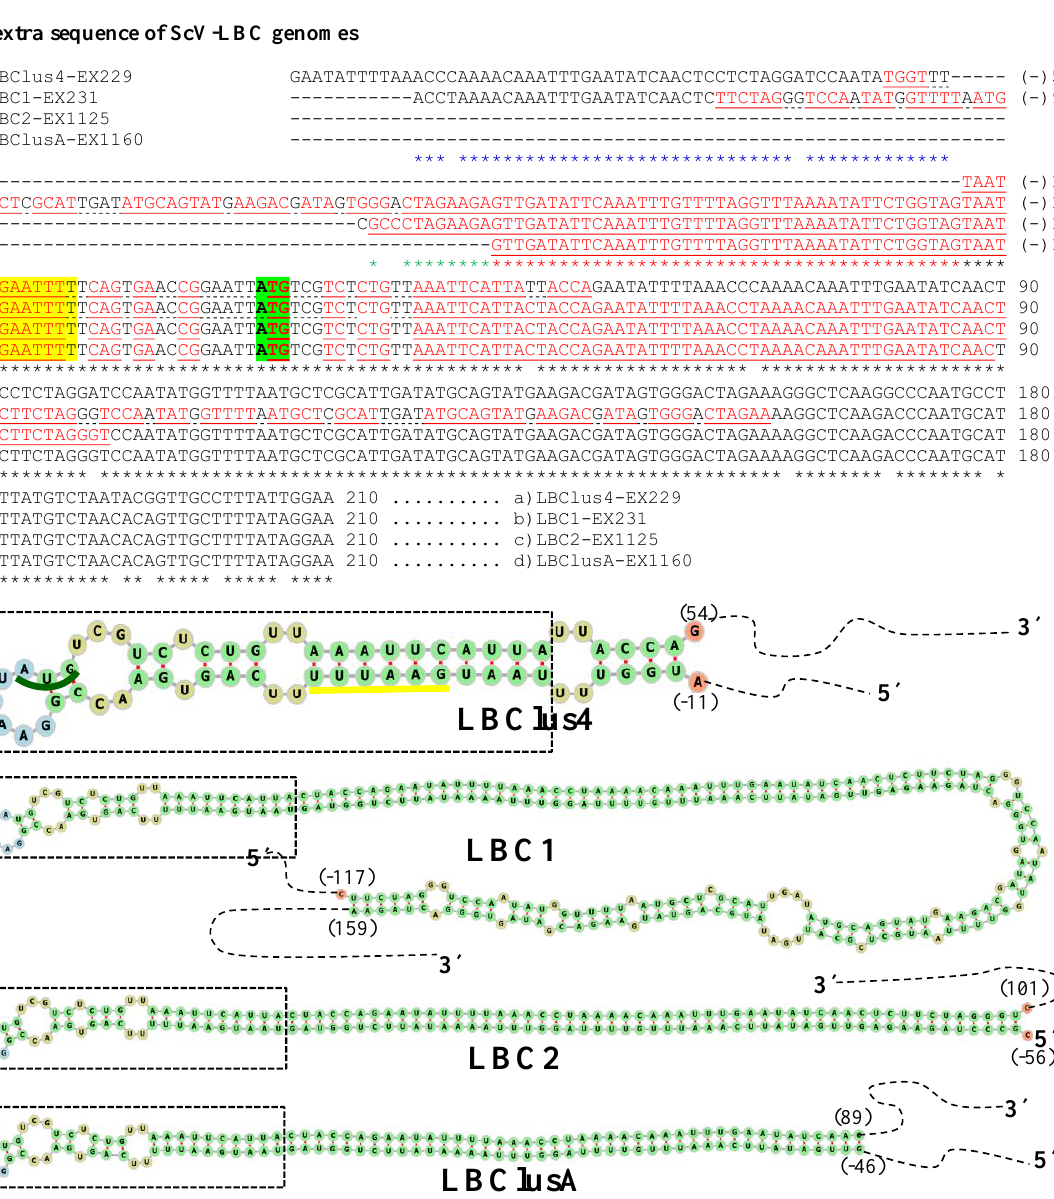
Figure 3. Nucleotide sequence (cDNA) alignment of 5 ′ -extra sequences and proximal canonical sequences of ScV-LBC genomes from S. cerevisiae : ( a ) LBClus4-EX229, ( b ) LBC1-EX231, ( c ) LBC2-EX1125, and ( d ) LBClusA-EX1160. Black asterisks (*) indicate identical nucleotides in all genomes. Red asterisks (*) indicate identical nucleotides in ( b ) LBC1-EX231, ( c ) LBC2-EX1125, and ( d ) LBClusA-EX1160 genomes. Blue asterisks (*) indicate identical nucleotides in ( a ) LBClus4-EX229 and ( b ) LBC1-EX231 genomes. Green asterisks (*) indicate identical nucleotides in ( b ) LBC1-EX231 and ( c ) LBC2-EX1125 genomes. The 5 (cid:48) -GAATTTT of canonical sequences is yellow highlighted. The protein synthesis initiation codon of Gag-Pol is green shaded. Nucleotides of palindromic sequences are shown in red letters. Stem-loops are underlined. The unpaired nucleotides of each loop are dot underlined. The secondary RNA structures of possible 5 ′ stem-loops are shown at the bottom of the sequences.